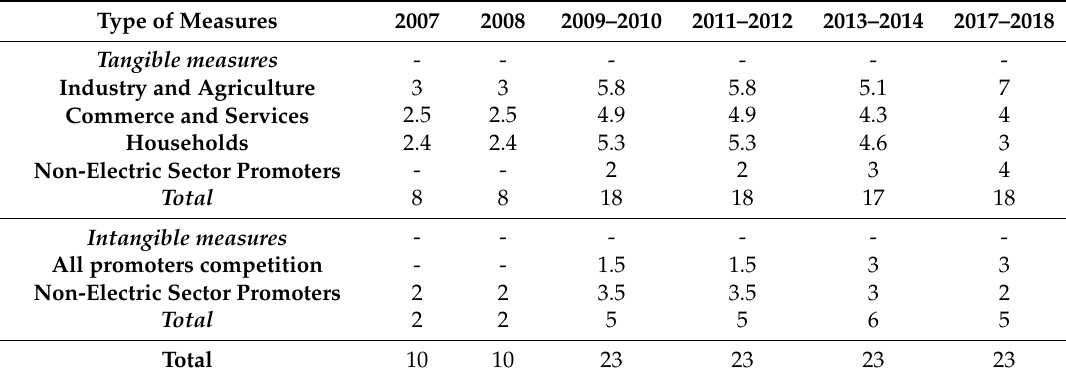
Table 3. Allocation of funds (in millions of Euros) by type of measure, consumer segment and competition, to each PPEC edition [19–25].